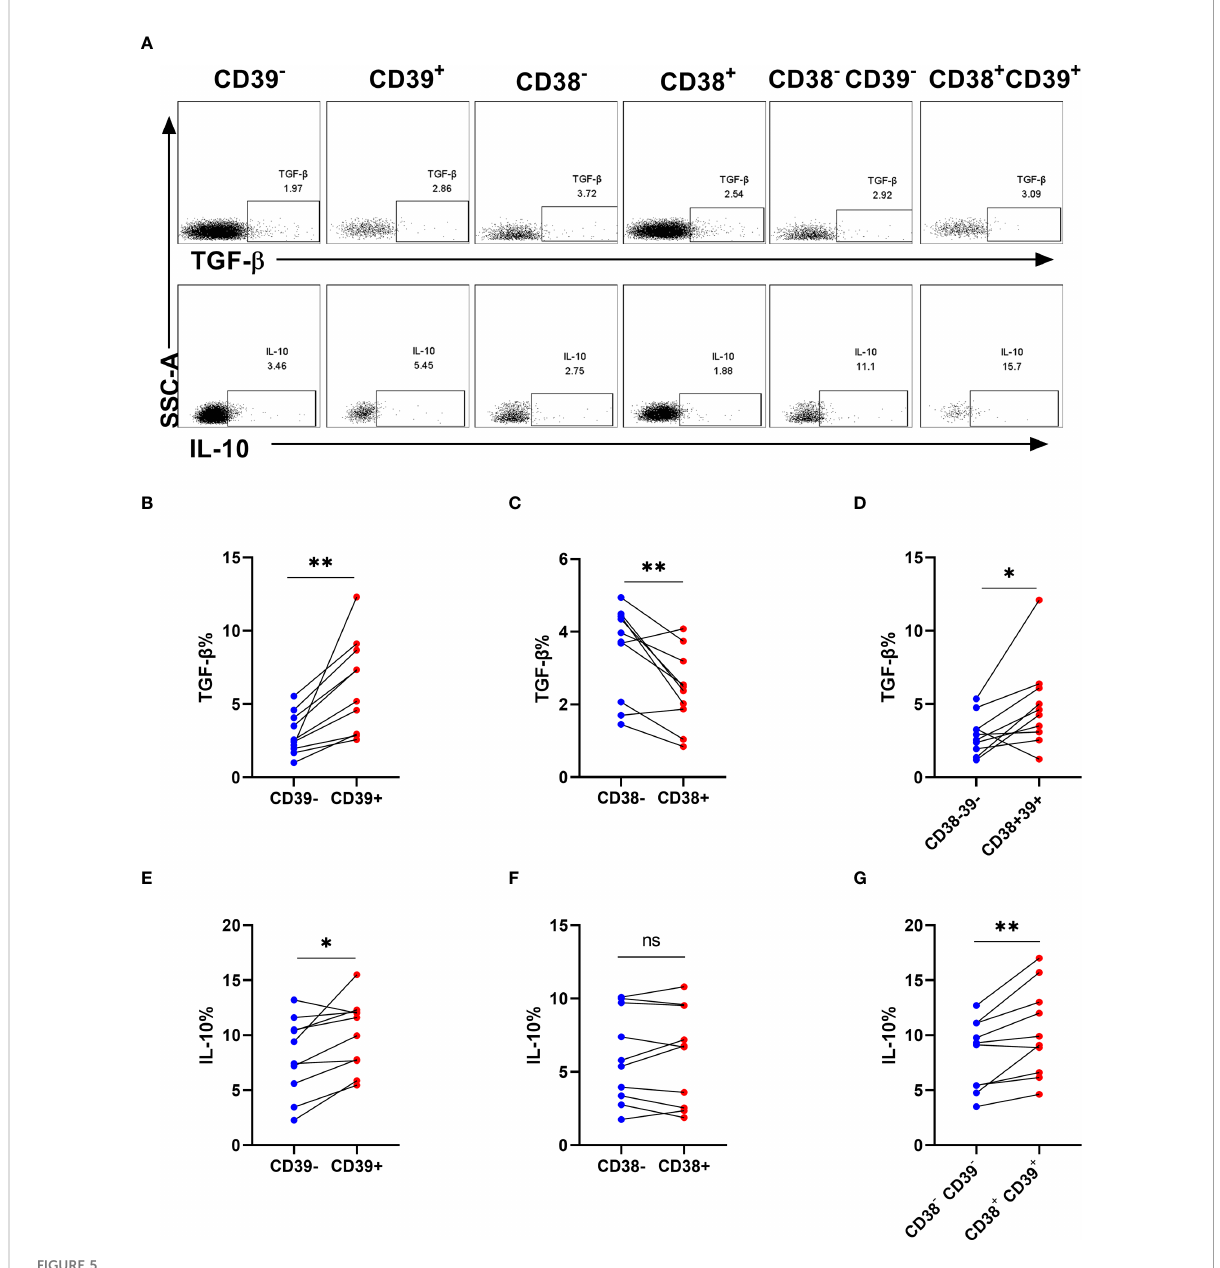
FIGURE 5 The proportion of TGF- b and interleukin-10 on CD38+ or/and CD39+ NK cells. (A) The representative fl ow cytometry spots showing the production of TGF- b and IL-10 in CD39 - , CD39 + , CD38 - , CD38 + , CD38 - CD39 - , and CD38 + CD39 + NK cells from HIV infected individuals. (B – D) Comparison of the production of TGF- b between CD39 - and CD39 + NK cells (B) , CD38 - and CD38 + NK cells (C) , CD38 - CD39 - and CD38 + CD39 + NK cells (D) from HIV infected participants stimulated with PMA/ionomycin for 6 h. (E – G) Comparison of the production of IL-10 between CD39 - and CD39 + NK cells (E) , CD38 - and CD38 + NK cells (F) , CD38 - CD39 - and CD38 + CD39 + NK cells (G) from HIV infected participants stimulated with PMA/ionomycin for 6 h. *p < 0.05, **p < 0.01, ns: no signi fi